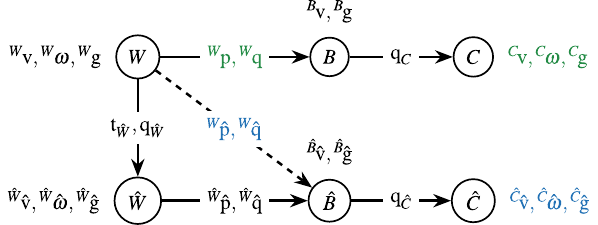
Figure 2. Reference frame tree with corresponding measurements and transformations. The top row shows the relationship between world ( W ), body ( B ) and calibrated ( C ) frame of the OTS as well as the measurements used in the following analysis highlighted in green. The second row shows the relationship between world ( ˆ B ˆ C ( ) and calibrated ( ) frame of the T265 as well as the measurements used in the following analysis highlighted in blue. The dashed arrow denotes the estimate of the T265’s position and orientation with respect to the OTS world